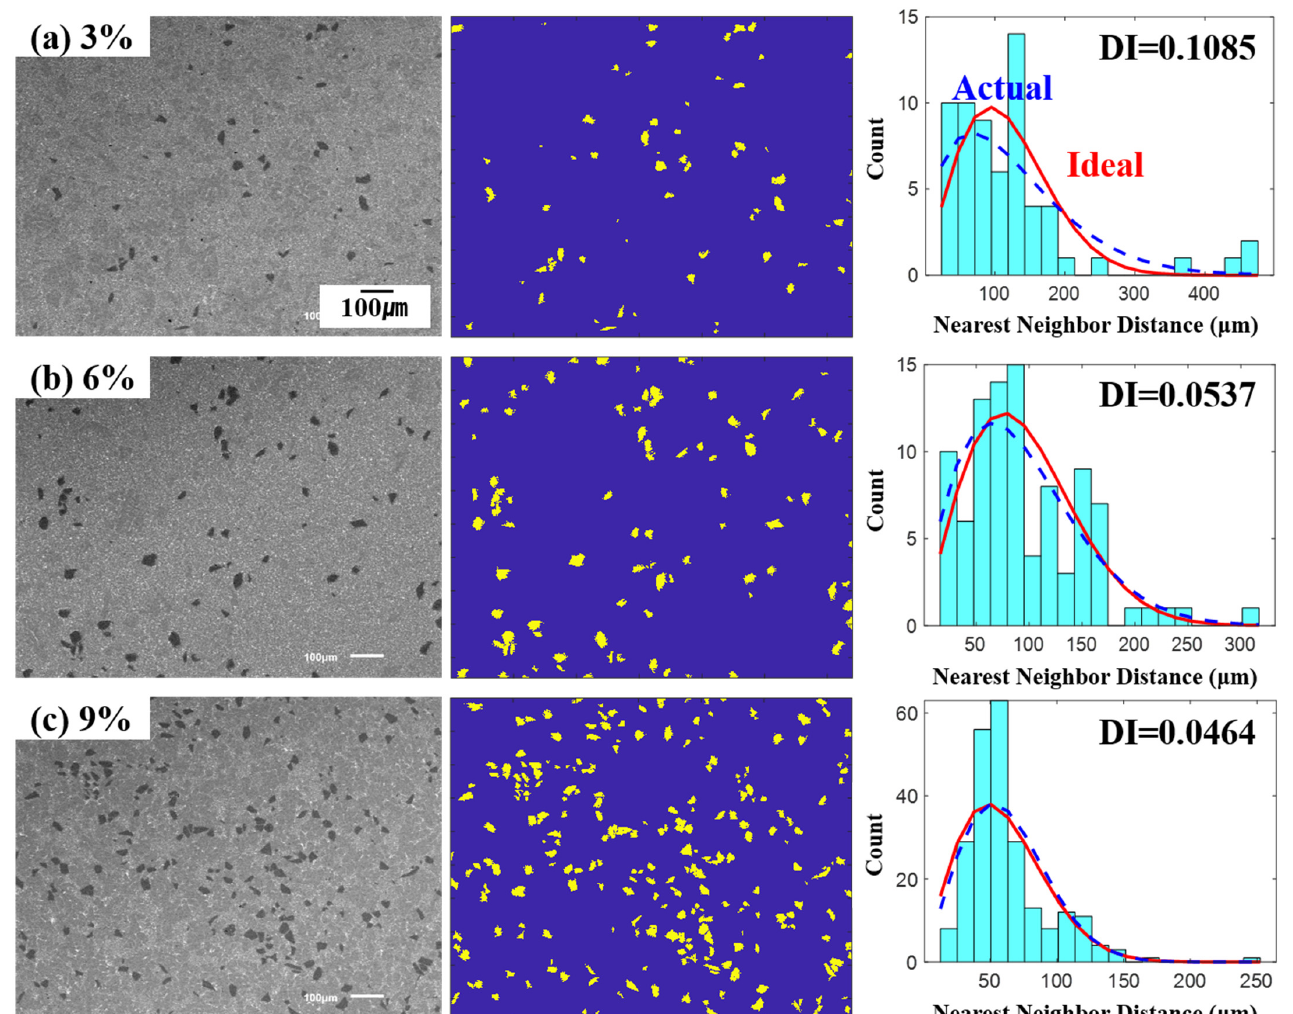
Figure 6. Degree of particle dispersion by the DC process: ( a ) 3 vol.%, ( b ) 6 vol.%, and ( c ) 9 vol.%.